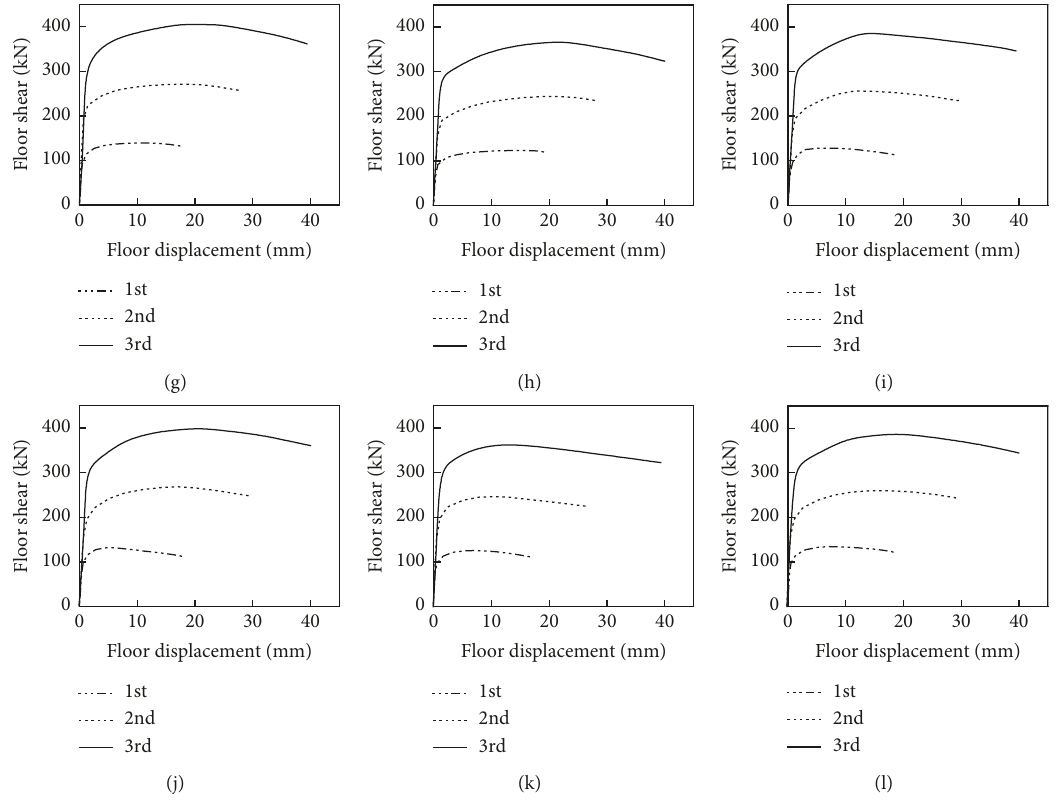
Figure 7: Horizontal floor force-lateral displacement curve 1&4/B-C. (d) Dem 3|1&4/B-C. (e) Dem 1|2&3/B-C. (f) Dem 2|2&3/B-C. (g) Dem 3|2&3/B-C. (h) Dem 1|1&4/A-B. (i) Dem 2|1&4/A-B. (j) Dem 3|1&4/A-B. (k) Dem 1|2&3/A-B. (l) Dem